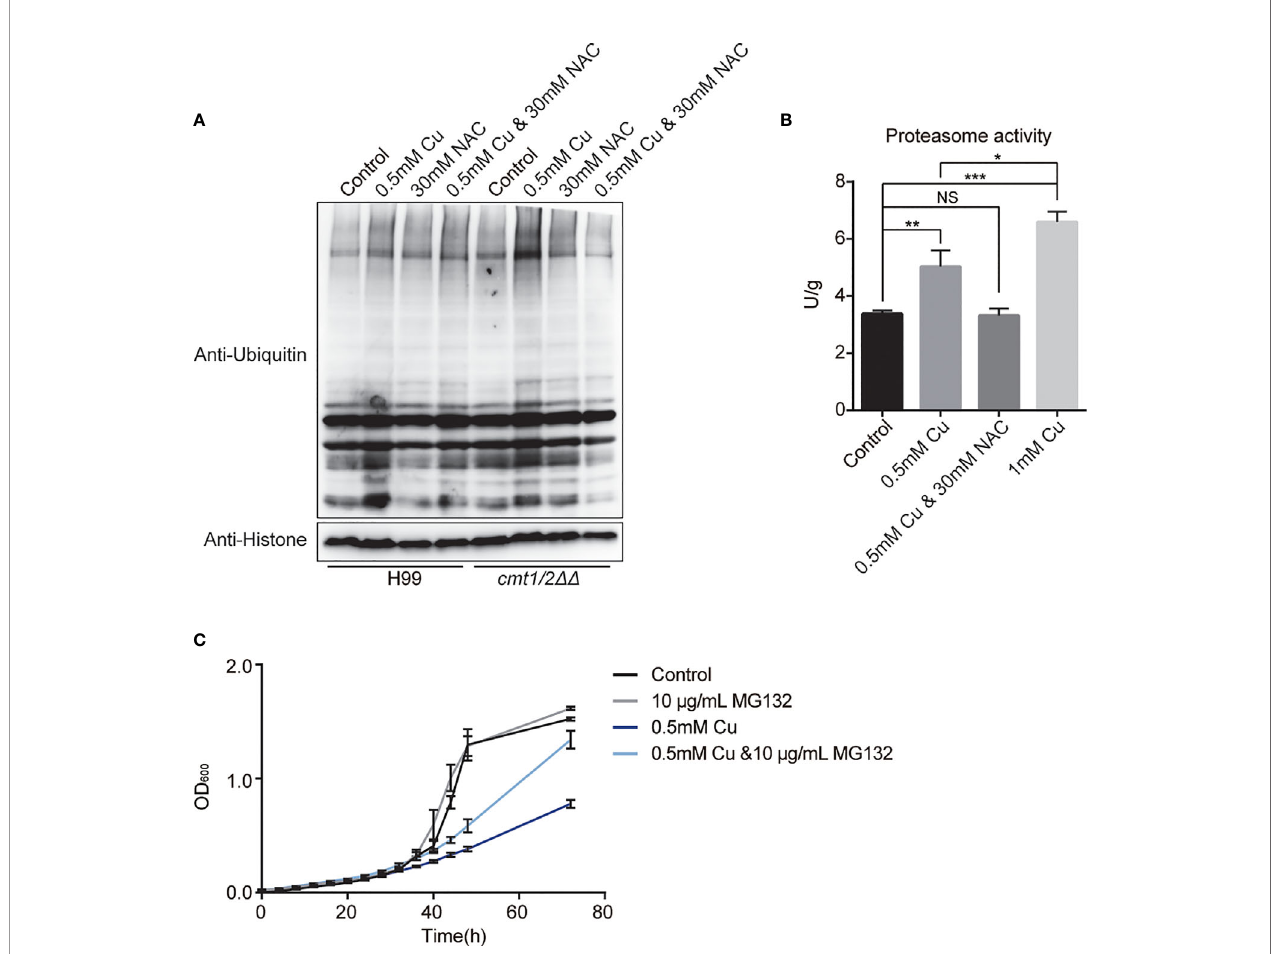
FIGURE 6 | Ubiquitin-mediated proteolysis under copper (Cu) stress. (A) Western blot analysis of ubiquitinated proteins in the wild-type strain H99 and Cu-sensitive mutant cmt1/2 DD . Cells were treated with 0.5 mM Cu, 30mM NAC,0.5 mM Cu plus 30mM NAC, respectively in yeast extract peptone dextrose (YPD) medium. The grayscale of the bands is positively correlated with the relative expression of ubiquitination level of total proteins. (B) Proteasome activity assay of cmt1/2 DD under Cu stress. cmt1/2 DD mutant was induced by 0.5 mMCu, 1 mMCu, or both 0.5 mMCuand 30 mMN-acetylcysteine (NAC)in YPD medium for 4 h.*p-value <0.05, **p-value <0.01, ***p-value<0.005 (n=3). NS, not signi fi cant. The fl uorescence of thesamples was quanti fi ed usingthe standard substance in the proteasome activity assay kit. Proteasome activity isshown inU/g protein. Histone was used as an internalreference. (C) Growth (based on opticaldensity at 600 nm) of cmt1/2 DD under Cu stress was affected bythe proteasome inhibitor MG132. cmt1/2 DD was incubated in YPD mediumwith or without 0.5 mM Cu and10 m g/mL MG132